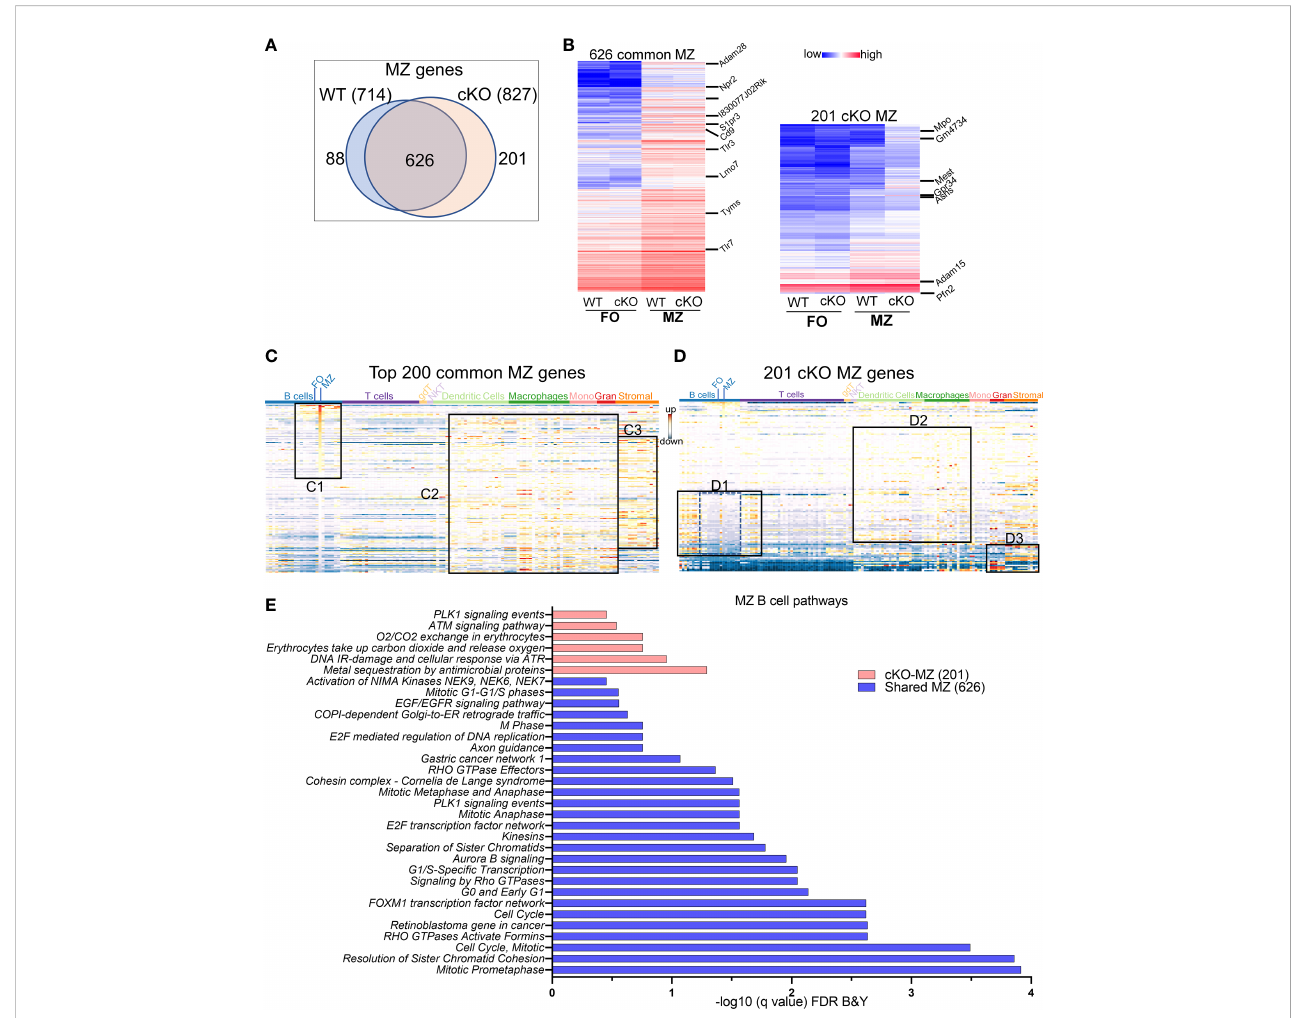
FIGURE 4 MZ B cell de fi ning transcriptome in WT and cKO mice. Total RNA was extracted from MZ B cells of WT and cKO mice. The RNA was used for bar-coded library preparations and sequencing (A) Venn diagram showing the genes that are common verses the ones that are unique to MZ B cells between the WT and the cKO mice. (B) Heatmap demonstrating average counts (CPM, n=2) normalized by DESeq2 of the 626 MZ common genes (right panel) and of the 201 unique cKO genes (left panel). (C) Top 200 common MZ genes were queried against the ImmGen-Database and the heatmap representing